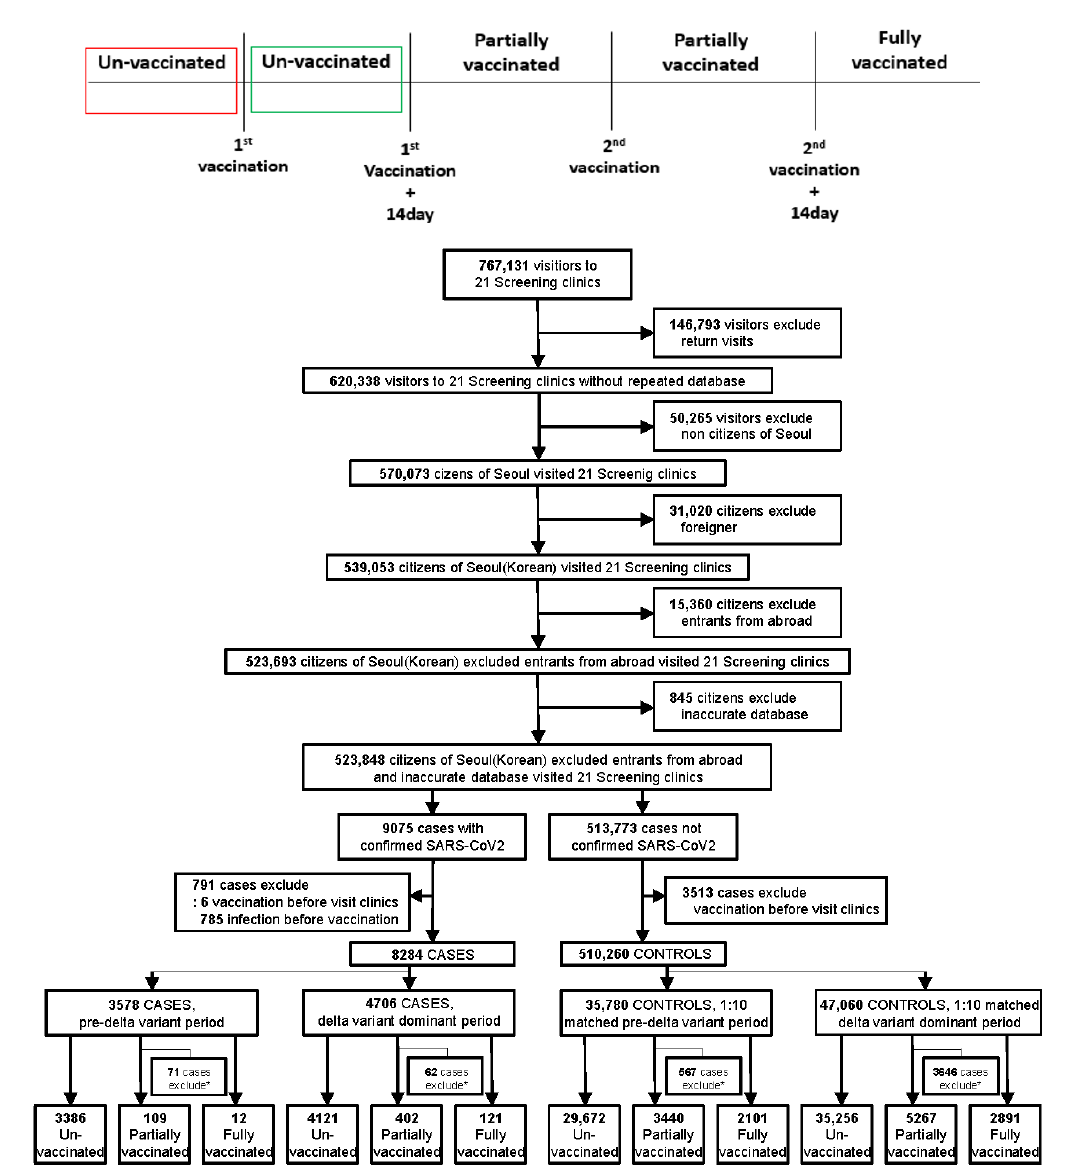
Figure 1. Classification criteria for the vaccination groups and flowchart of cases and controls selected in the pre-delta-dominant period and the delta-dominant period. ( A ) Classification criteria for the vaccination group established in consideration of vaccination and whether 14 days had elapsed from the date of vaccination. ( B ) Flowcharts showing the selection process for cases (PCR-positive) and controls (PCR-negative) in the pre-delta-dominant period and the delta-dominant period to investigate the reduction in COVID-19 vaccine effectiveness against SARS-CoV-2.